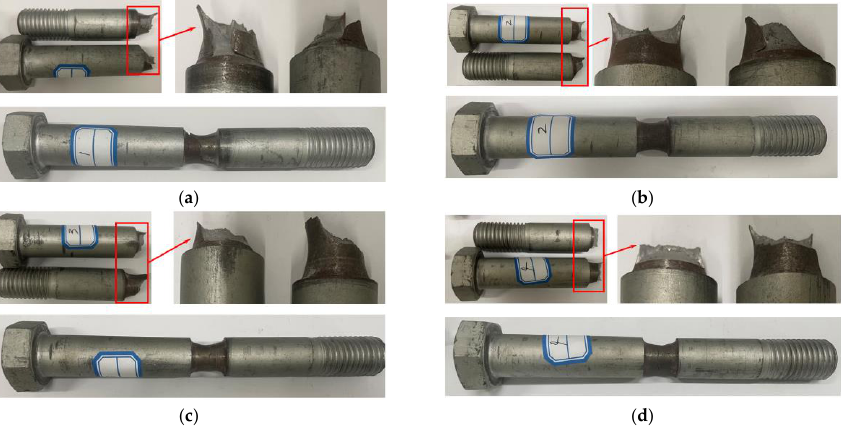
Figure 17. VCSB-induced failure deformation and fracture cross-section: ( a ) Test 1 (T P = 0 N ∙ m), ( b ) Test 2 (T P = 430 N ∙ m), ( c ) Test 3 (T P = 610 N ∙ m), ( d ) Test 4 (T P = 820 N ∙ m).